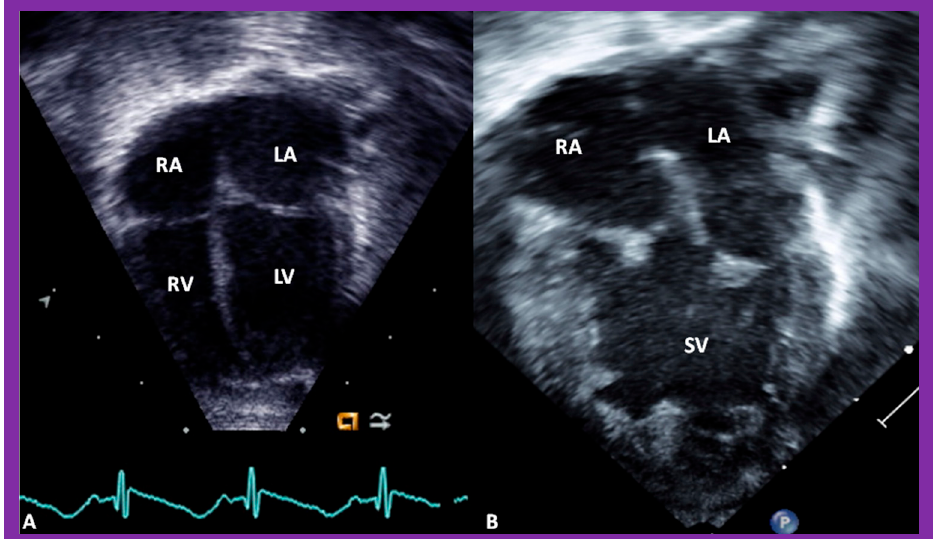
Figure 30. Selected pictures from apical four-chamber echo views of two children, the first ( A ), who has two ventricles, and the second ( B ), who has one (single) ventricle (SV). The left atrium (LA), left ventricle (LV), right atrium (RA), and right ventricle (RV) are labeled. Reproduced from reference [4].